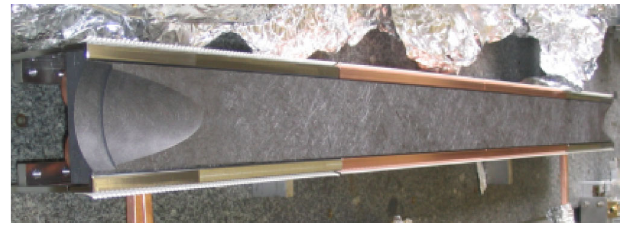
FIG. 2. (Color) A collimator jaw of the same type as installed in the SPS. The figure is taken from [31].